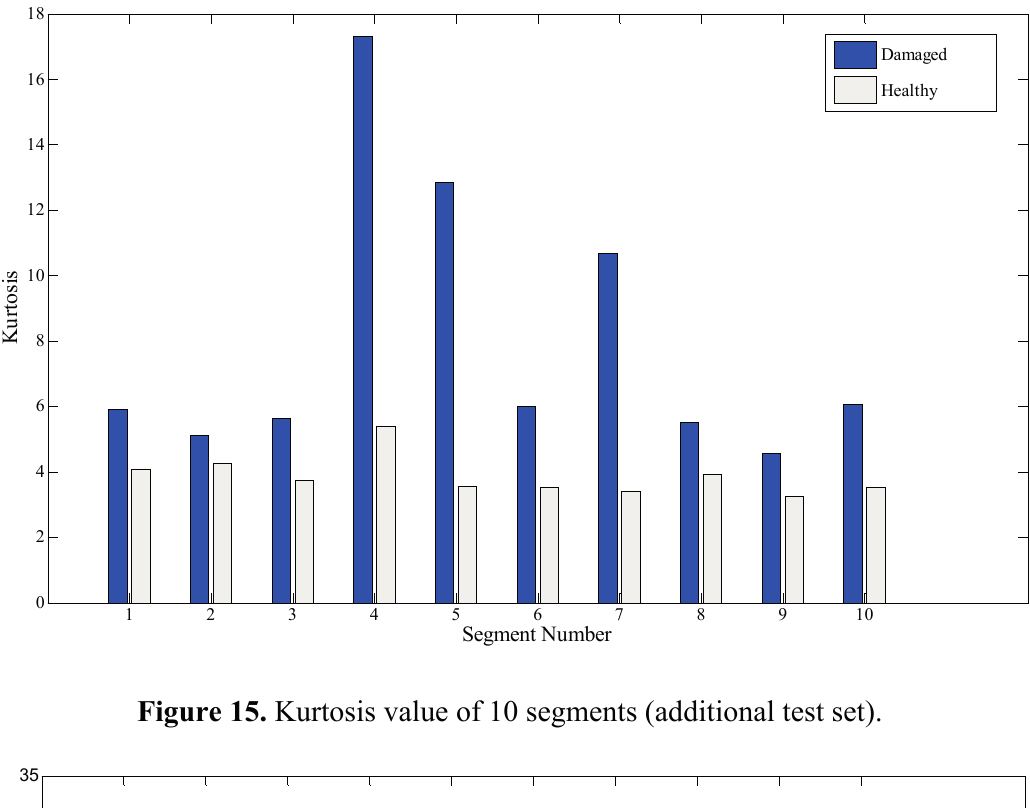
Figure 14. Kurtosis value of 10 segments.